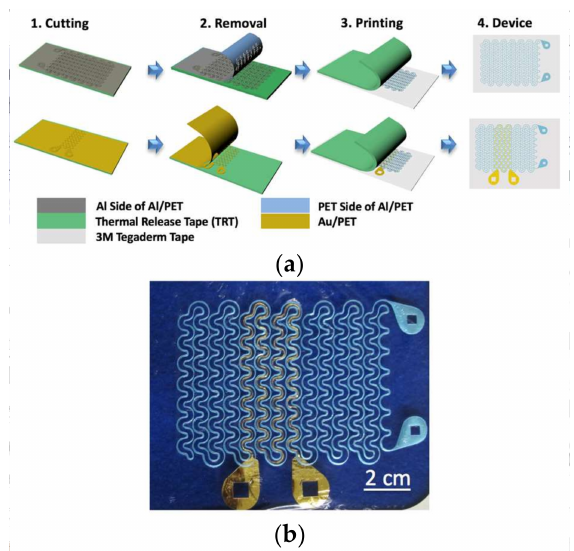
Figure 1. ( a ) Fabrication process used for heater and resistance temperature detector (RTD), shown for heater. Material is put on the thermal release tape (TRT) and cut with Silhouette cutter. TRT is heated, excess material is removed and remaining material is transferred to Tegaderm; ( b ) Complete device on tegaderm. Aluminum with blue polyimide backing forms the resistive heating element while Au/Cr 100/10 nm forms the resistance temperature